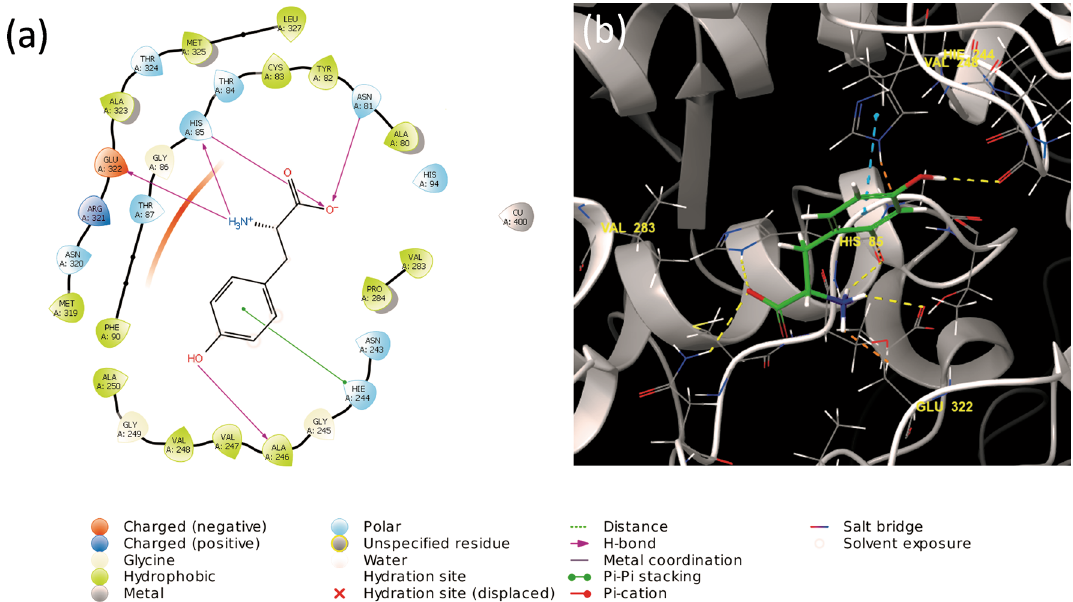
Figure 3. ( a ) Two- and ( b ) three-dimensional ligand interaction diagrams of L-tyrosine docked within the tyrosinase structure (PBD: 2Y9X). The blue dashed line in image ( b ) represents pi-pi stacking, while the yellow and orange dashed lines represents different hydrogen bonds between the compounds and the active site residues of the enzyme (https:// www. schro dinger. com/ maest ro; version 12.1.013, release